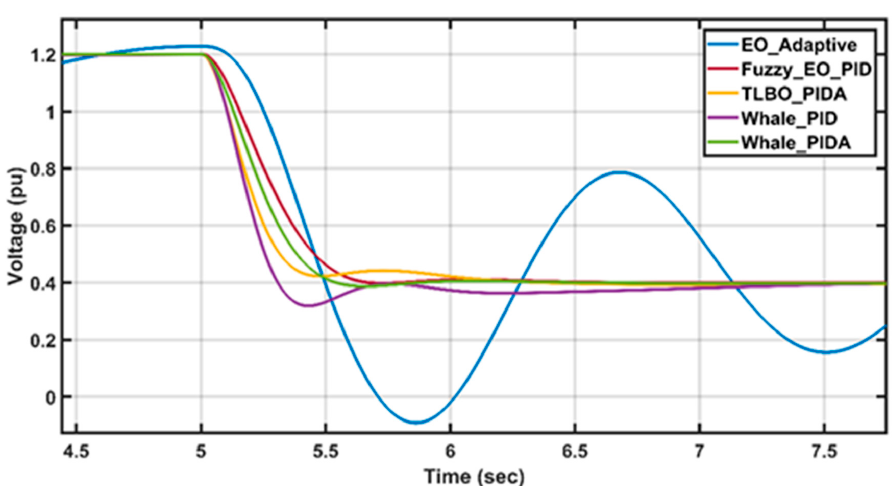
Figure 16. Focusing part 2 on the dynamic reference case.